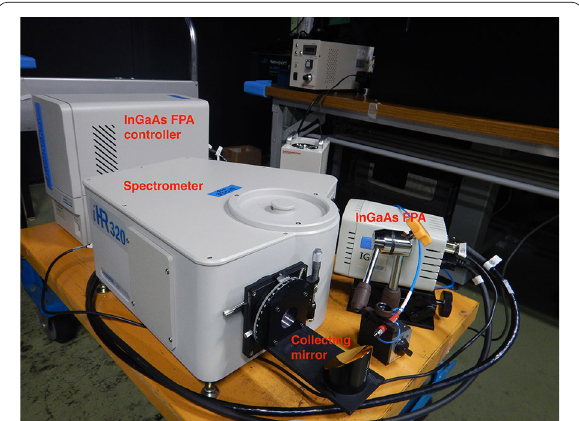
Fig. 1 A photo of the NIRAS system in a